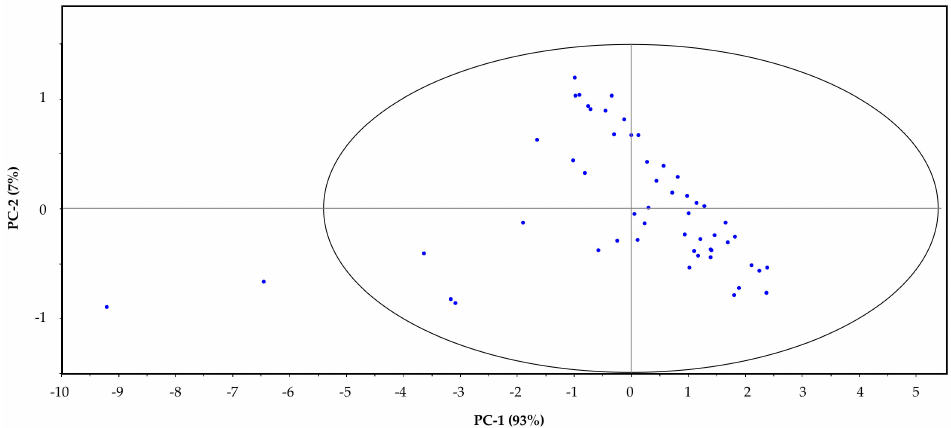
Figure 3. Principal component analysis with Hotelling’s T 2 ellipse analysis for outlier detection in the calibration set.